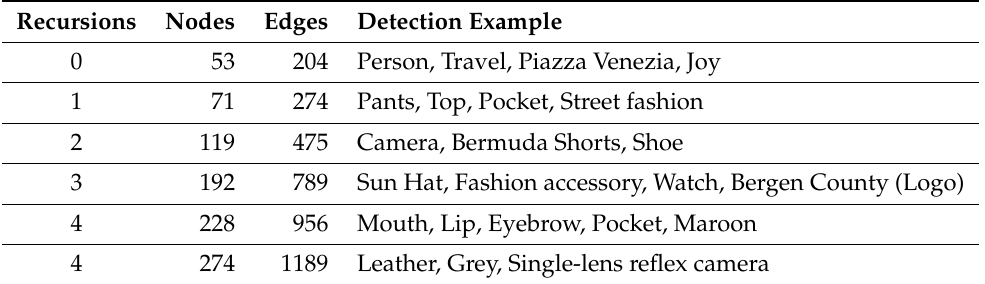
Table 5. Experiment 3—GMAF processing and object detection based on recursion